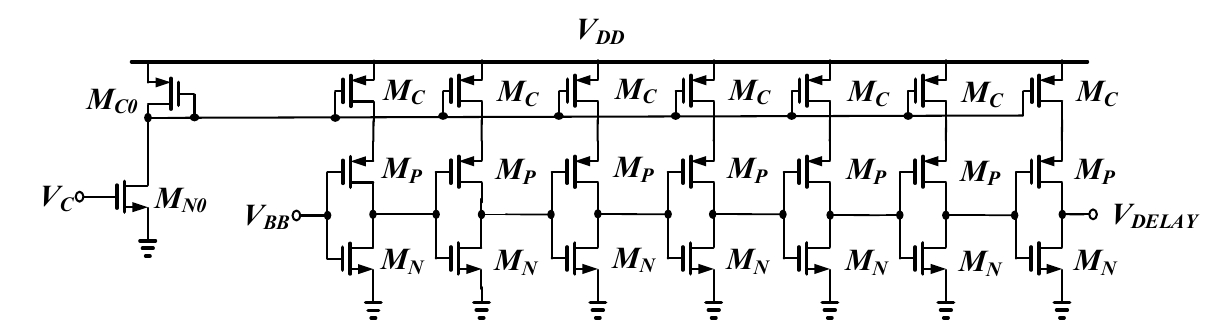
Figure 6. Schematic of the delay stage.